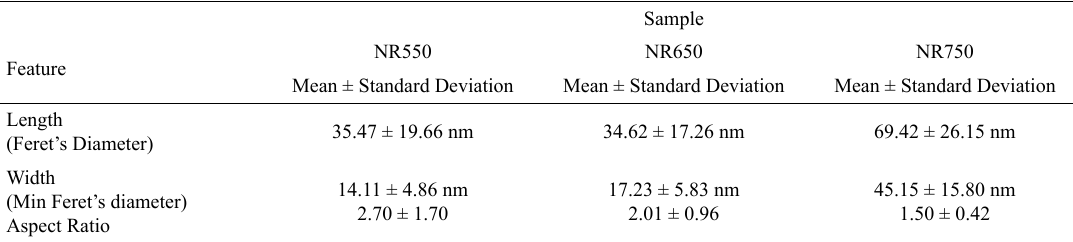
Table 1. Average particle size and aspect ratio for the samples NR550, NR650 and NR750.